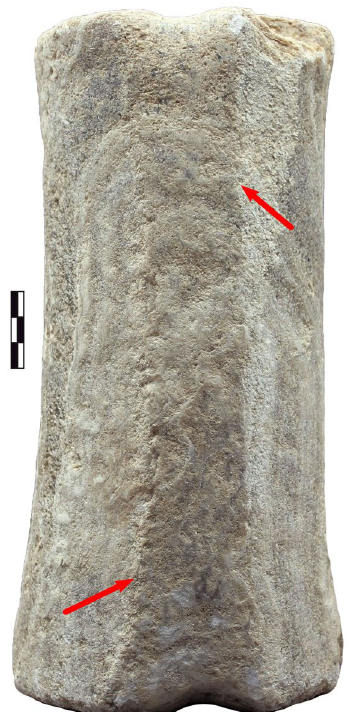
Figure 11. Miniature column from Gonur Depe with convex stripes instead of grooves on the side (from the depositories of the National Museum of Turkmenistan, Ashgabat). Scale bar is 3 cm long, separated into three 1 cm segments. Scale bar is 3 cm long, separated into three 1 cm